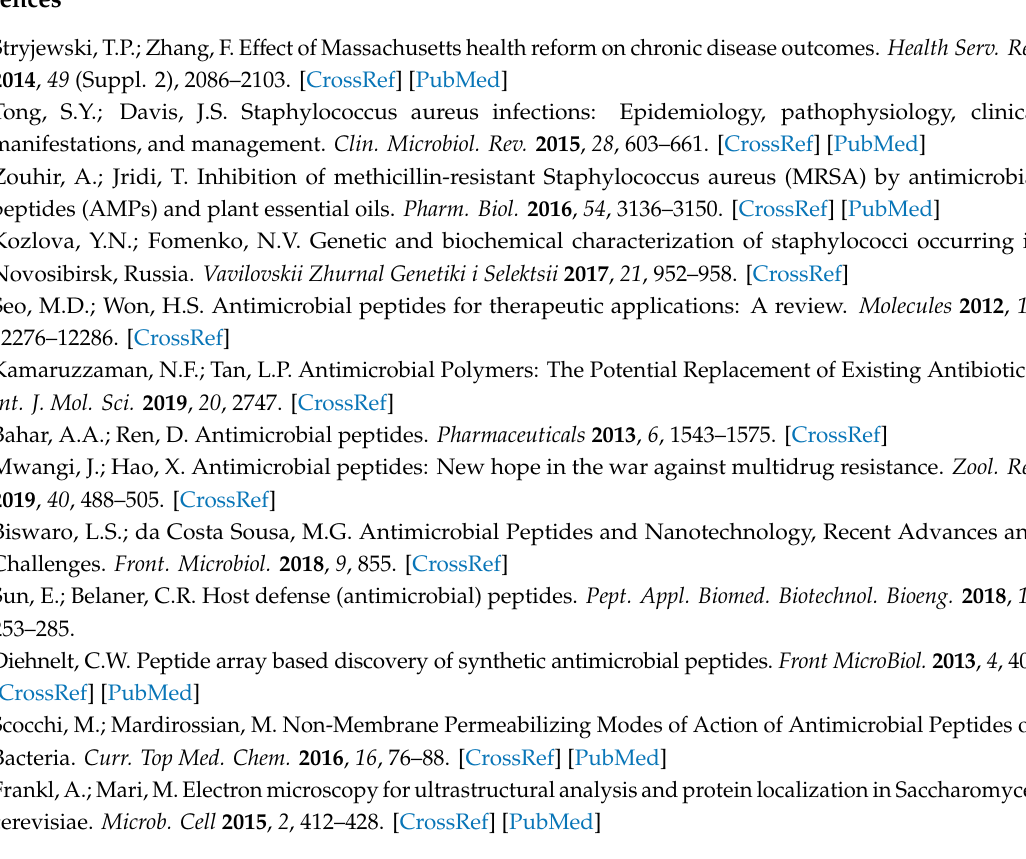
Figure S1: RP-HPLC of the purified R9F2 and (KFF)3K peptides on a Gemini column; Figure S2: Growth curve of S. aureus in LB-culture medium; Figure S3: Ultrastructure of S. aureus cells incubated with R9F2 and (KFF)3K peptides for 1 and 15 min; Figure S4: Ultrastructure of S. aureus envelope incubated with chlorhexidine for 15, 30, 60 min and 2